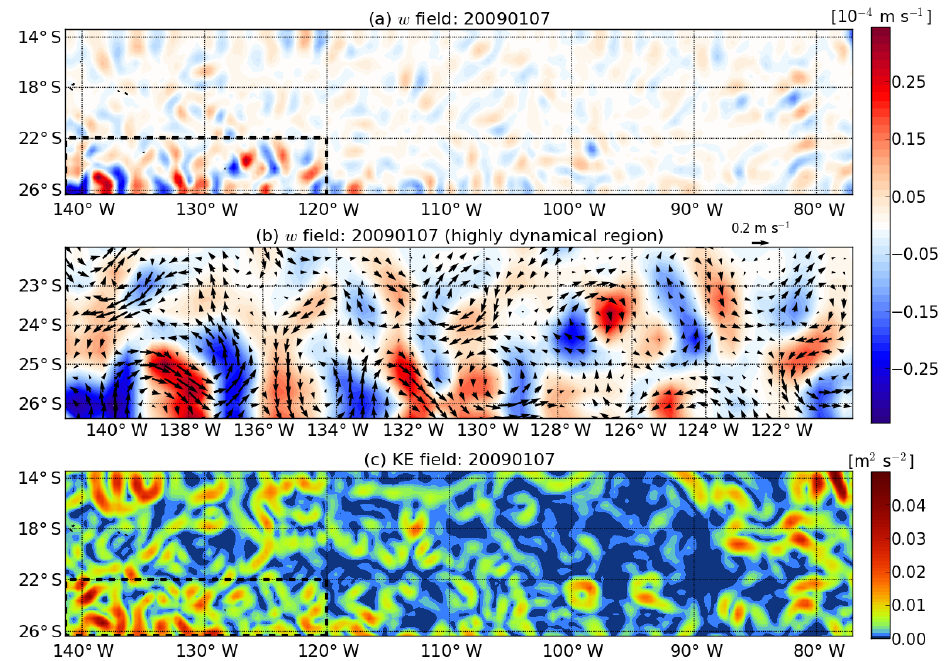
Figure 3. (a) Vertical velocity on 7 January 2009 at 200m depth. Black box delimits the region of high mesoscale eddy activity. (b) Zoom of vertical velocity and horizontal geostrophic currents over the high mesoscale eddy activity region in (a) . (c) Kinetic energy on 7 January 2009 at 200m